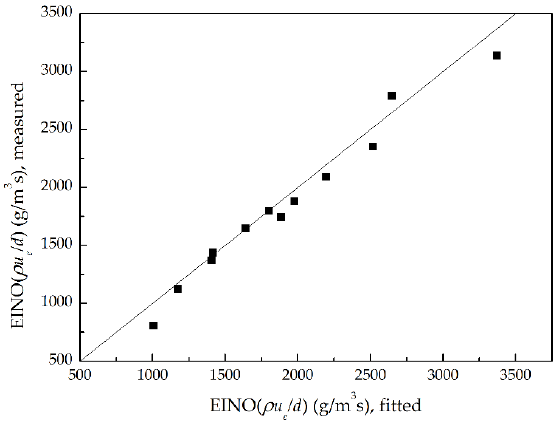
Figure 16. Prediction of EINO ( ρu e / d ) from its correlation.